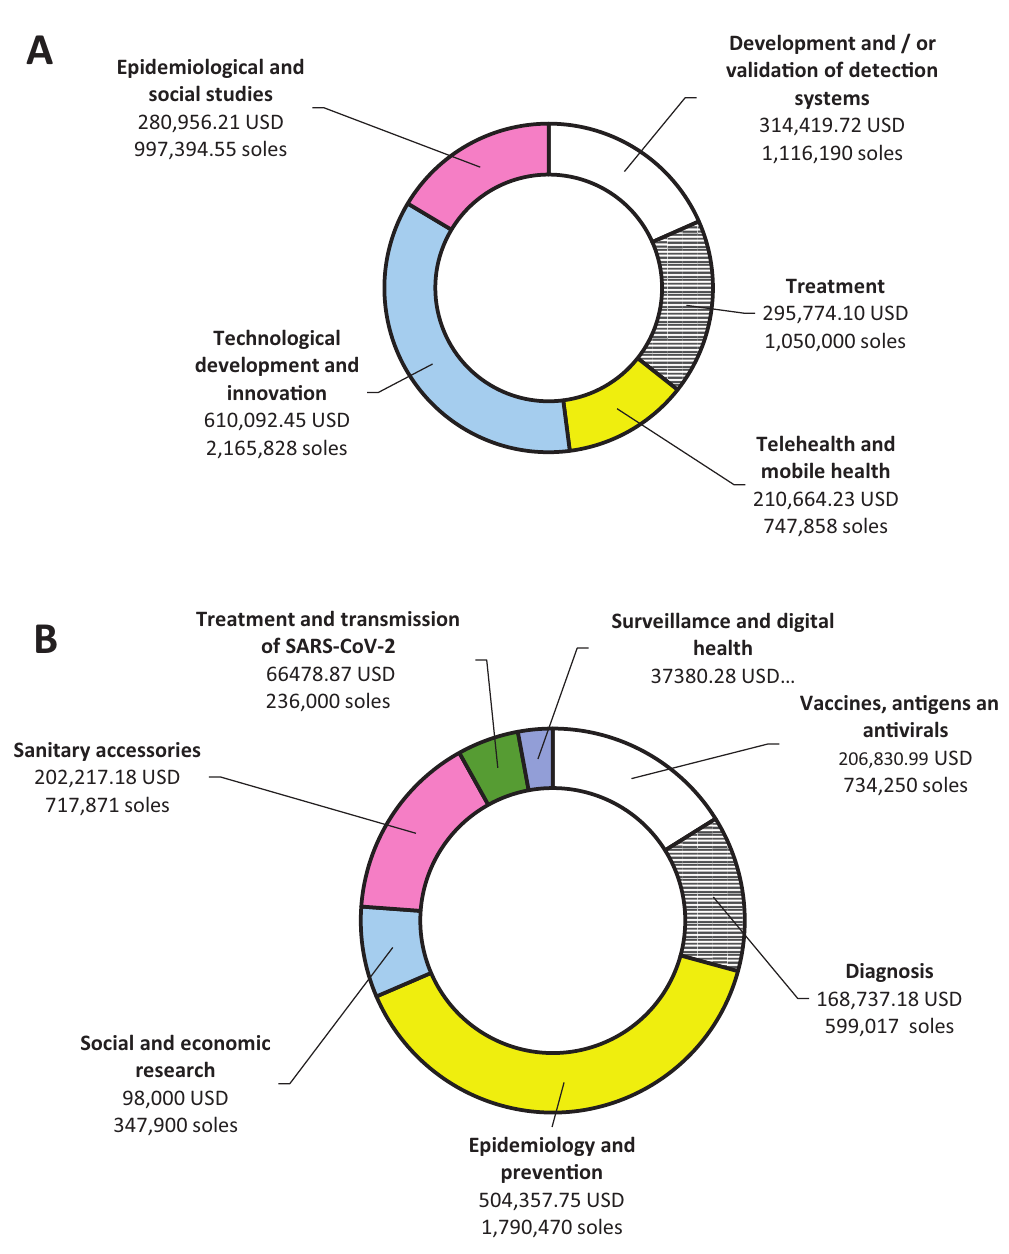
Figure 2. Projects financed in the two calls. Budget approved for each theme for the winning projects of the Special Projects: Response to COVID-19 contest for first (A) and second (B)